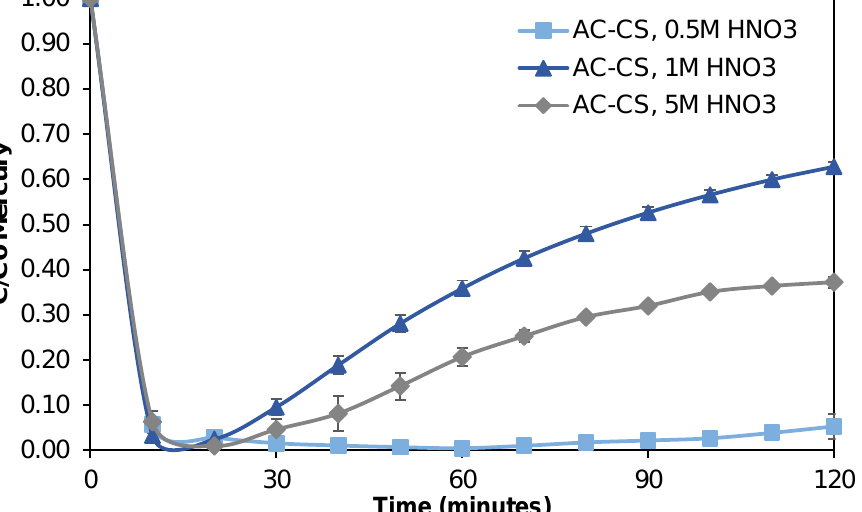
Figure 9. Mercury removal for coconut-based activated carbons treated with increasing nitric acid concentrations.